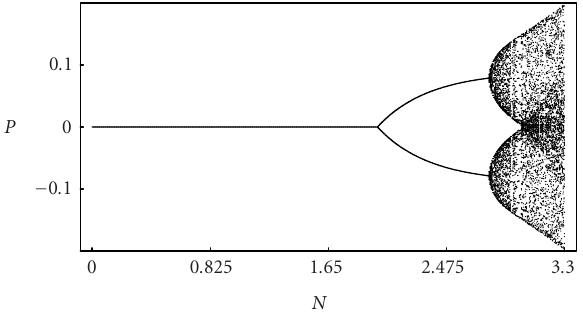
Figure 3.1. Bifurcation diagram for parameter N . Parameter N is increased from 0 to 3.3 in 500 steps. Each time, prices are plotted for t =